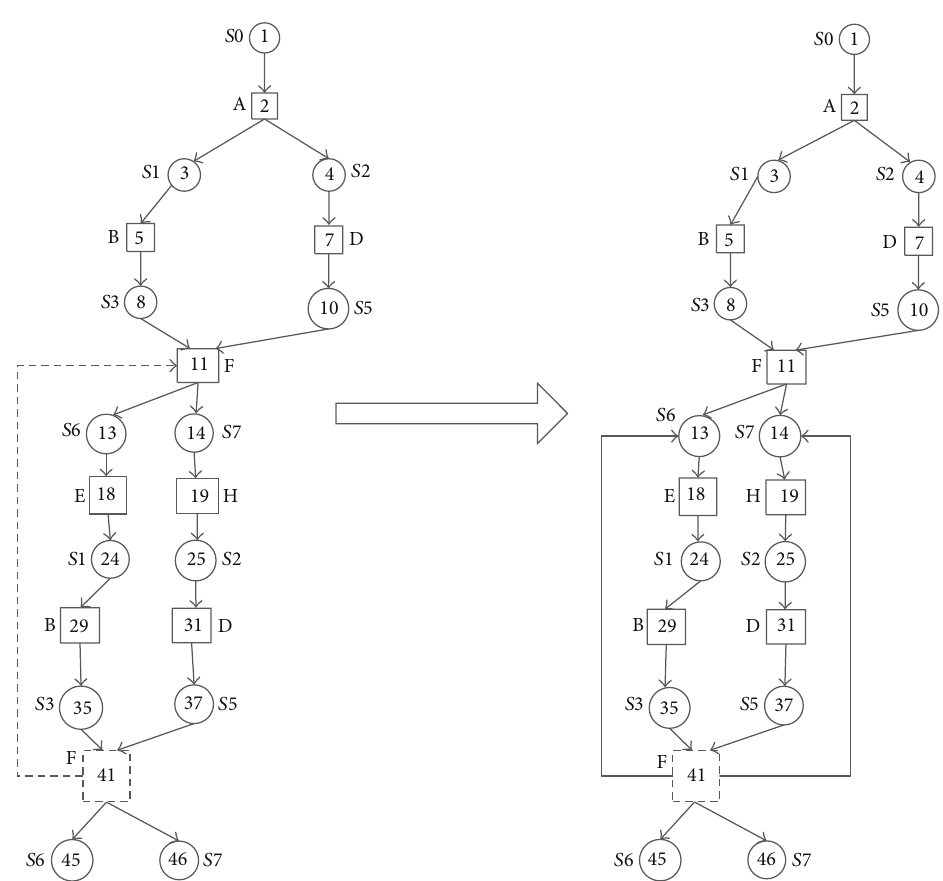
Figure 8: Converting a conflict-free annotated CFP to a directed bigraph.